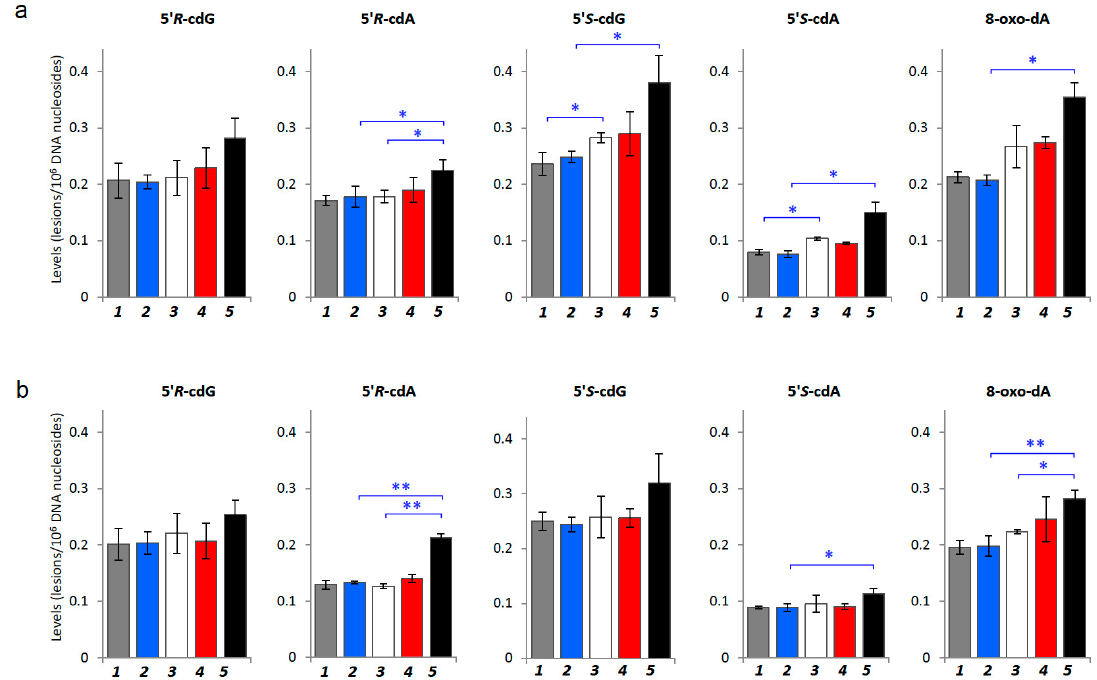
Figure 3. DNA lesion levels measurement by LC-MS / MS in tissues. ( a ) Levels of DNA lesions in genomic DNA isolated from liver of control SCID mice ( Group 1 : 4-weeks; Group 2 : 17-weeks old) and tumor-bearing SCID mice ( Group 3 : 4-weeks old; Group 4 : 5-weeks old; Group 5 : 17-weeks old). ( b ) Levels of DNA lesions in genomic DNA isolated from kidney of control SCID mice ( Groups 1 and 2 ) and tumor-bearing SCID mice ( Groups 3 , 4 and 5 ). Statistical analysis was performed using t -test by comparing the means of control SCID and tumor-bearing SCID mice at each specific age point (Two-Sample Assuming Unequal Variances) and error bars represent standard deviation of the mean, calculated from three independent animals. * denotes a statistically significant di ff erence ( p < 0.05) and ** denotes a statistically significant di ff erence ( p < 0.005) between the animal groups.